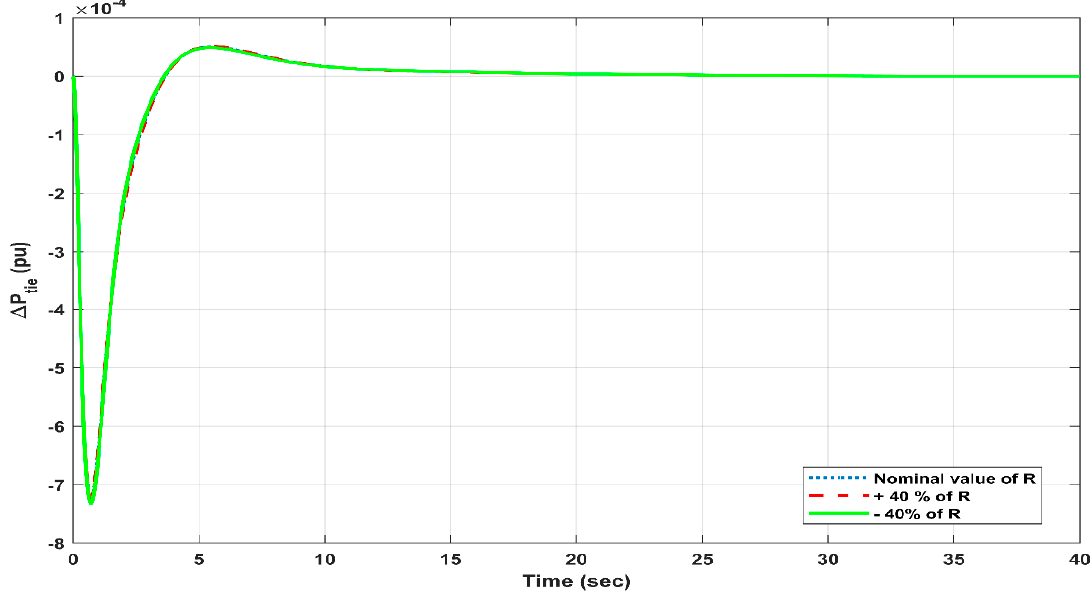
Figure 12. Sensitivity analysis for the system parameters. Table 4. Transient response computation for change in parameters of the power